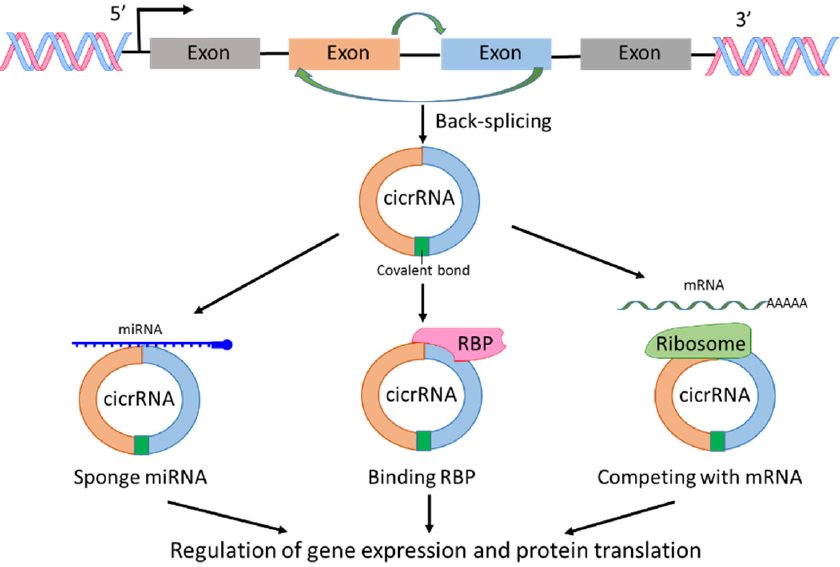
Figure 3. Biogenesis and functions of circRNAs. circRNA is produced by back-splicing and the fragments of RNA form a closed circular nucleotide structure connected by covalent bond. circRNAs interact with RNA binding protein (RBP), sponge with miRNAs and compete with mRNAs, leading to regulation of gene expression and protein translation.